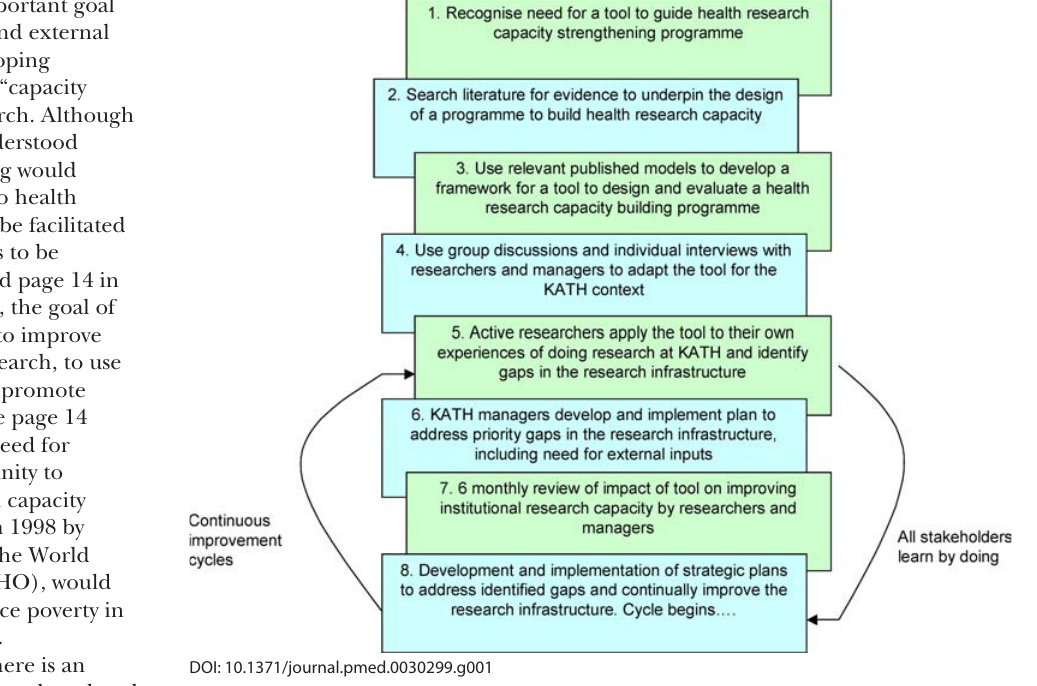
Figure 1. Outline of Programme to Develop and Test Tool for Evaluating Research Capacity at